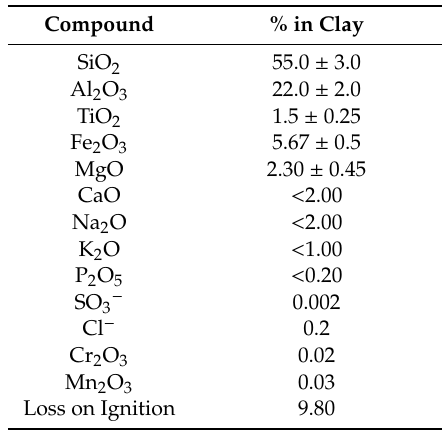
Table 2. Chemical composition (wt.%) of Saudi bentonite